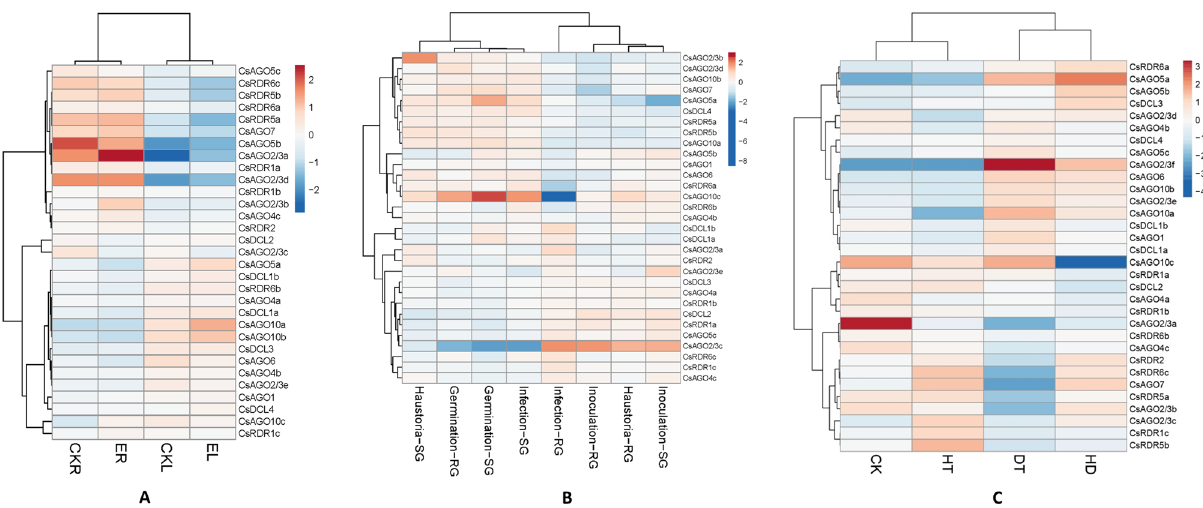
Figure 9. ( A ) Normalized expression profiles of AGO, DCL and RDR genes of C. sinensis in roots and leaves upon E. oblique infection (ER and EL) and non-infected plant (CKR and CKL). ( B ) Normalized expression profiles of AGO, DCL and RDR genes of C. sinensis during different stages of blister blight disease in susceptible (SG) and resistant (RG) genotypes. Four distinct stages of infection as depicted are as follows—Spore inoculation (Inoculation); Spore germination (Germination); Haustorial development (Haustoria); Sporulation and secondary infection (Infection). ( C ) Normalized expression profiles of AGO, DCL and RDR genes of C. sinensis under different conditions of abiotic stress (CK- control; HT- high temperature; DT- drought; HD- high temperature and